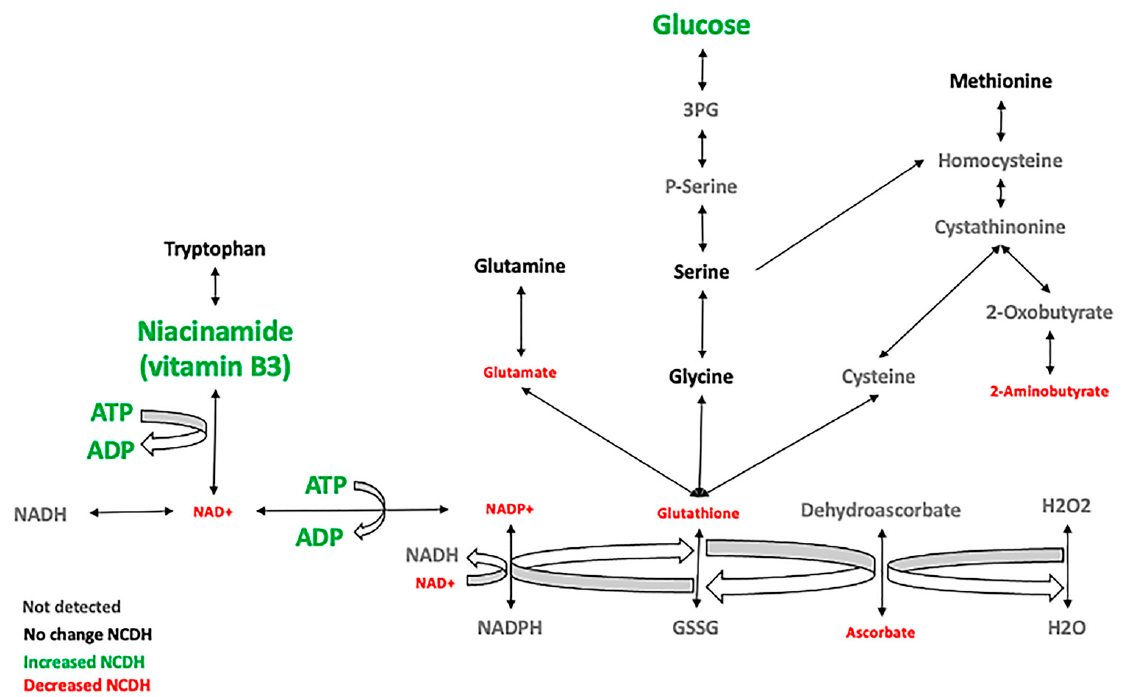
Figure 5. Decreased antioxidant levels in fetal CDH lungs. Schematic diagram of glutathione and niacinamide metabolism and changes identified in the NCDH group. Green (increased), red (decreased), black (no change), and grey (undetected).